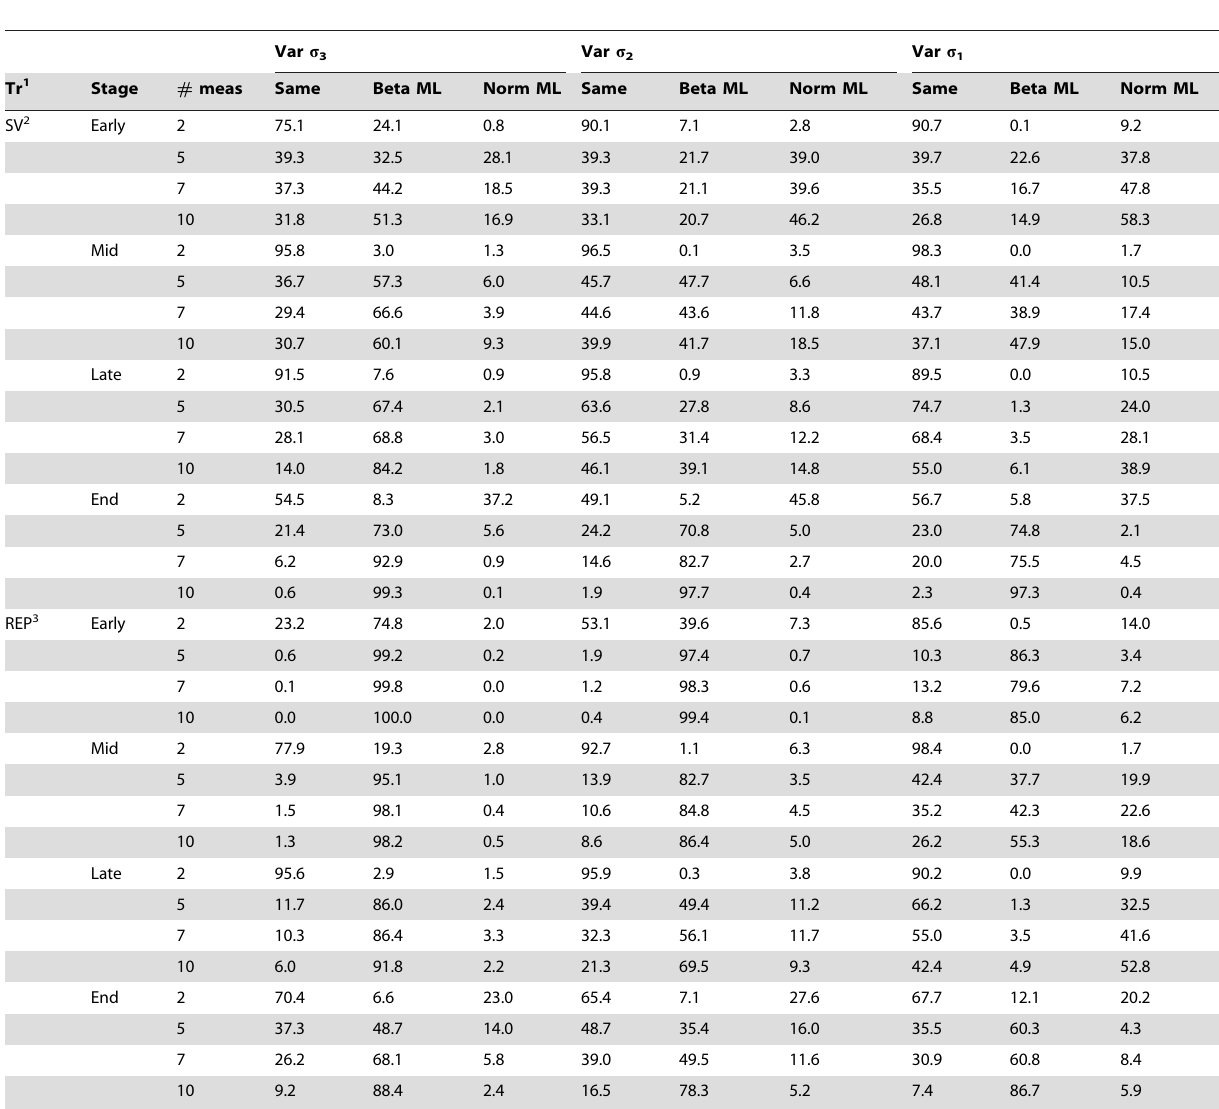
Table 6. Percent of variable normal s simulations for which AIC c selected maximum likelihood (ML) estimation with beta or normal errors best or found no difference between the models (Same) from each simulation ( k = 0.0002).